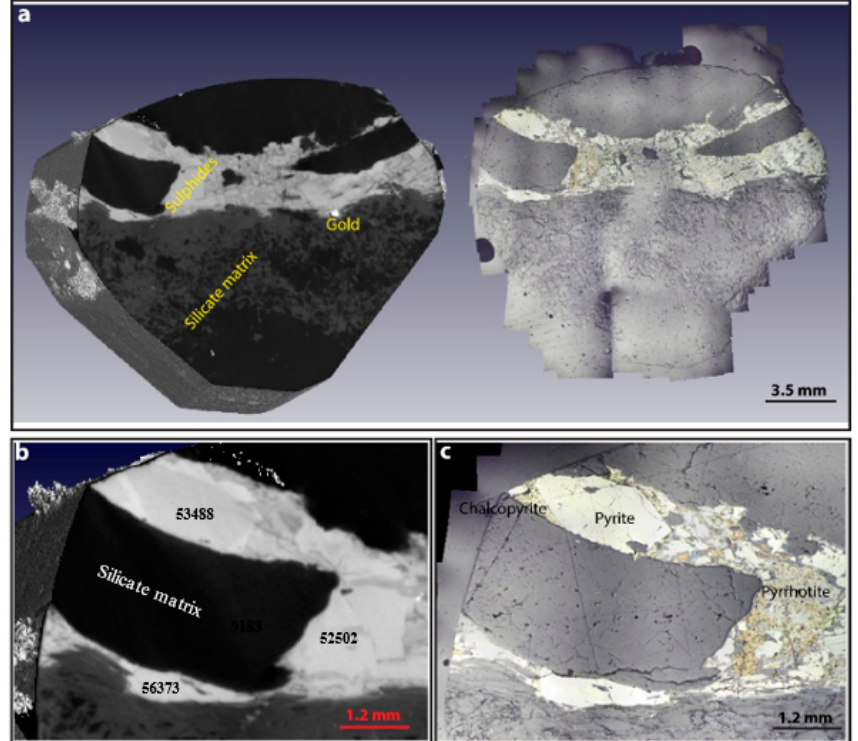
Figure 8. ( a ): Precise overlay of thin section and XCT scan images in 3D. The correlation was conducted manually by visually aligning prominent features using Volume Graphic software. A notable gold grain is intersected in the XCT image slice but was either slightly below the polished surface or was above the polished surface and was subsequently cut and polished away. The high-resolution X-ray computed tomography and microscopy analyses indicate that gold and accessory sulphides are not randomly distributed but rather follow specific orientation. They are distributed along shear fracture planes rather than disseminated throughout the cores. This suggests that gold was precipitated along the shear plane together with the sulphides during the ore-forming processes. The bright gold grain is not seen in reflected light microscopy, but it is easily seen in XCT image. ( b ) Zoomed in image of sulphides from XCT indicating that they cannot be differentiated due to a narrow density range. ( c ) The sulphide mineral assemblage comprises pyrite, pyrrhotite and chalcopyrite determined from detailed 2D examination of polished sections. Thick section cut from sample JJ04.